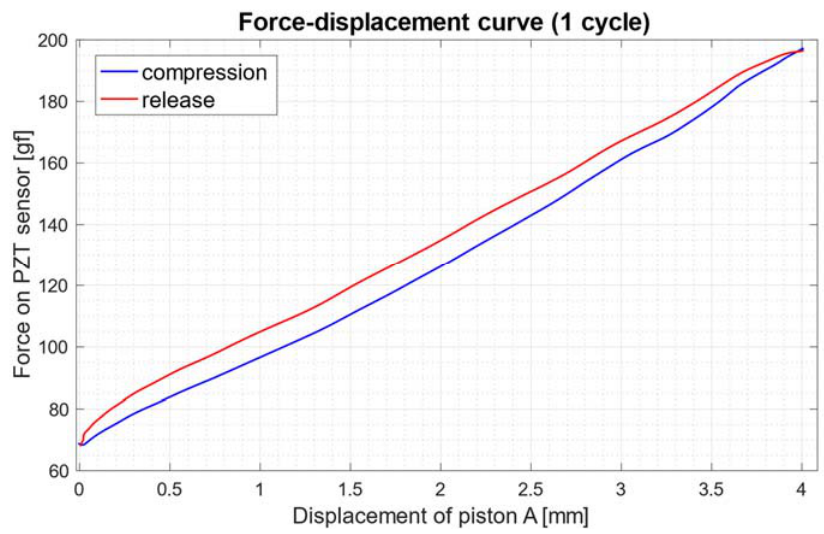
Figure 14. Relationship between the force applied on the PZT sensor and the displacement of piston A, for one stress cycle at 0.09 Hz. The hysteresis is graphically represented by the area between the curves depicted in red and blue.